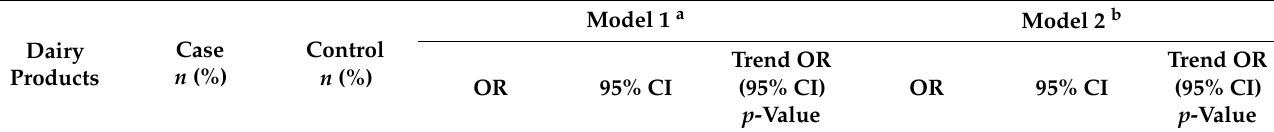
Table 4. Odds ratios (ORs) and 95% confidence interval (95% CI) of breast cancer by the dairy products consumption among Polish women residing in Gliwice, Katowice, Pozna´n and Białystok.